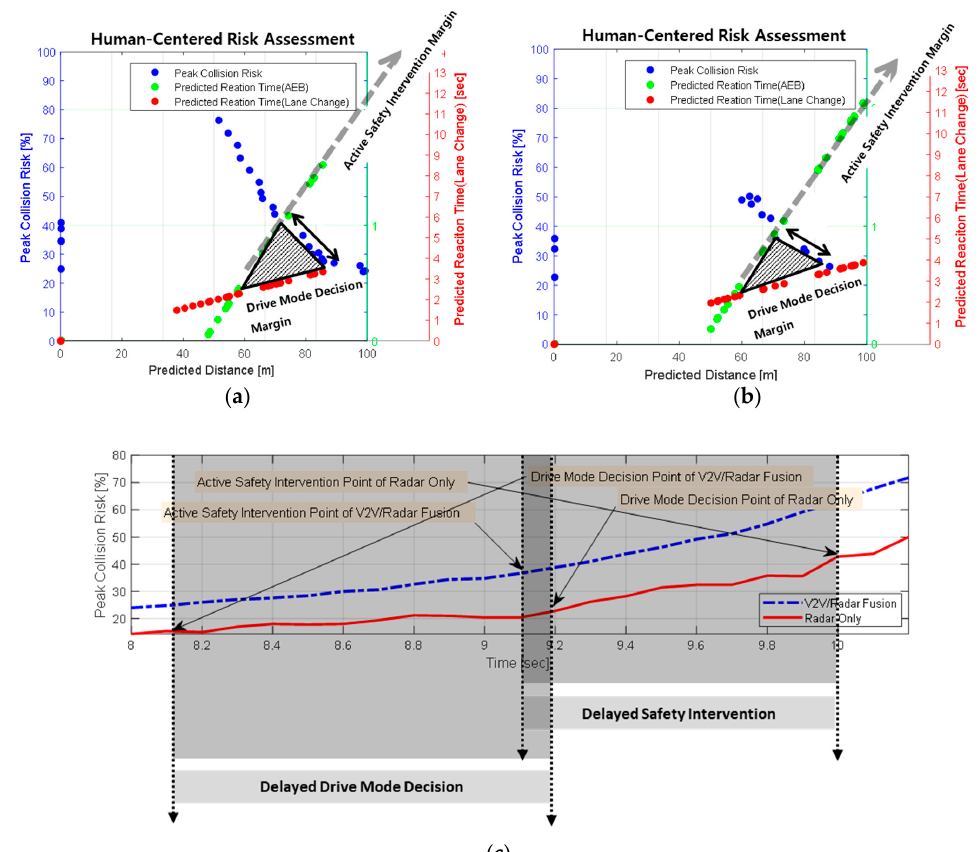
Figure 9. Parameters schematic view of collision probability-based risk assessment: ( a ) safe triangle analysis: V2V/Radar fusion; ( b ) safe triangle analysis: Radar only; ( c ) Peak collision risk of the vehicles: V2V/Radar fusion and Radar only.